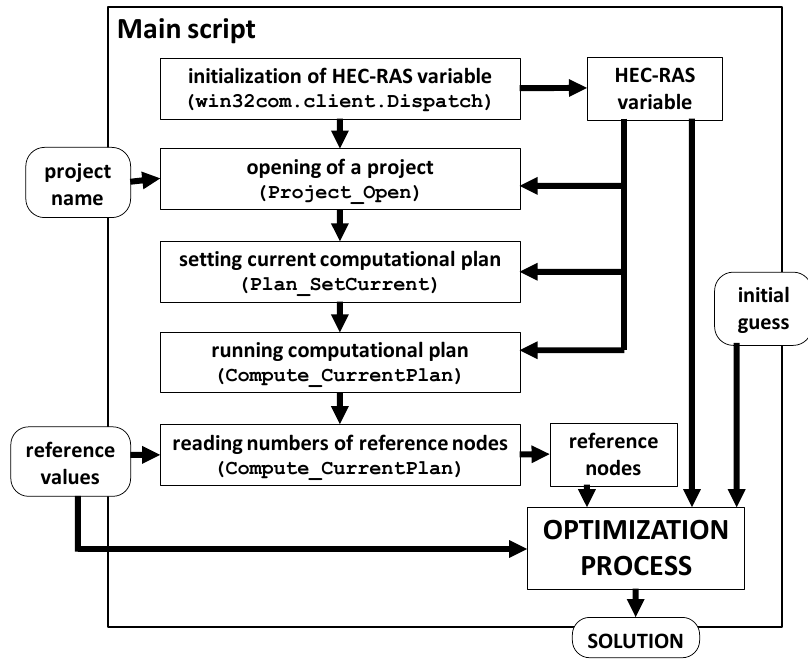
Figure 4. Main computational elements of Example 2.